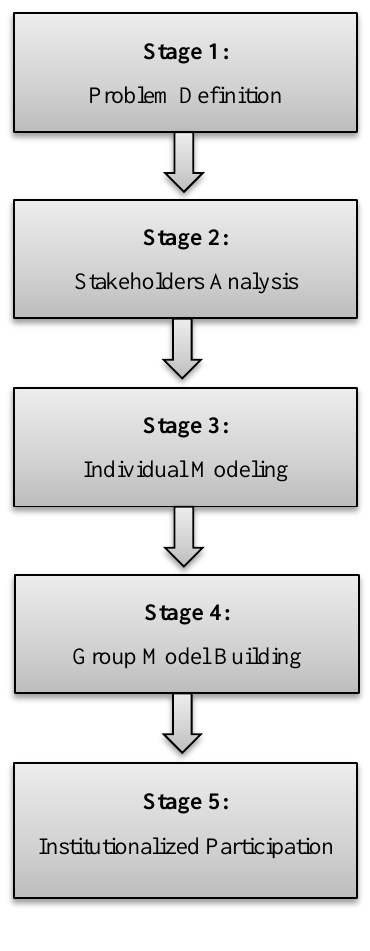
Figure 2. Participating modelling